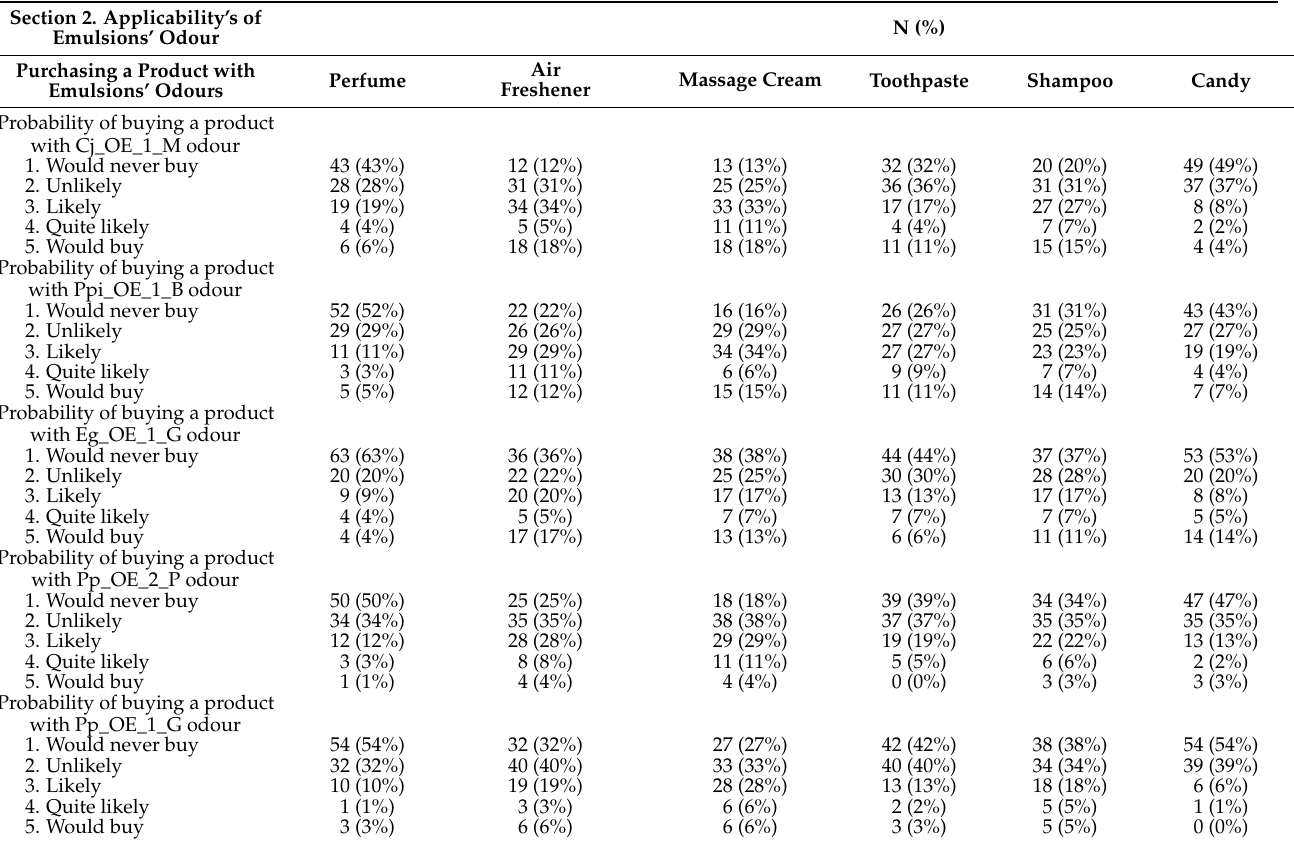
Table 8. Participants responses to purchasing a product with different emulsions’